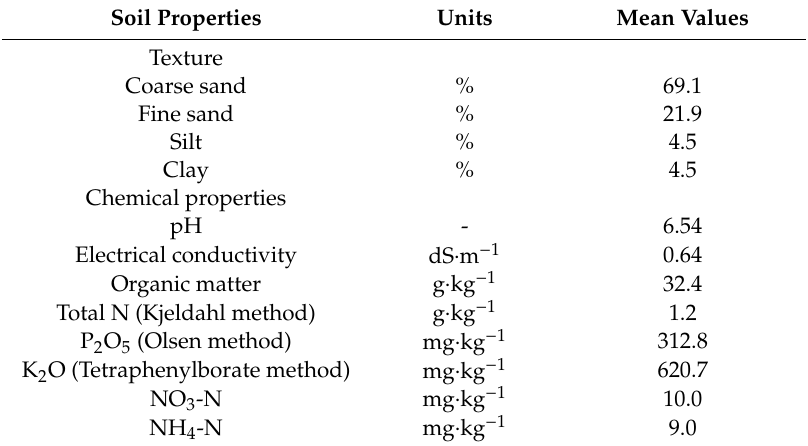
Table 1. Physical and chemical properties of the soil used in this